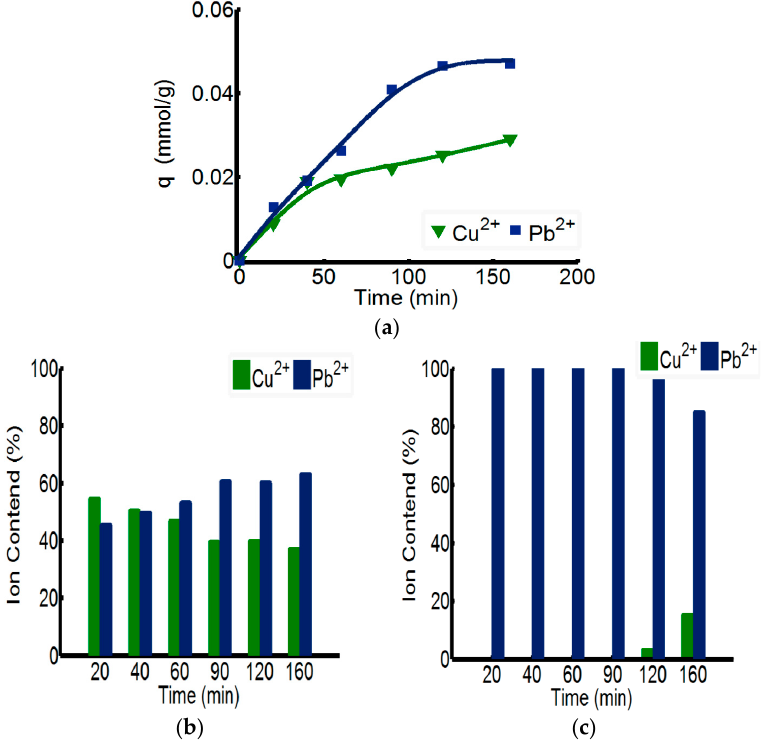
Figure 5. The adsorption capacity of ChW-PTW among Cu 2+ and Pb 2+ in a double-ion-mixed solution. ( a ) Adsorbing capacity of ChW-PTW with time; ( b ) the percentages of Cu 2+ and Pb 2+ in ChW film; and ( c ) the percentages of Cu 2+ and Pb 2+ in the PTW layer.